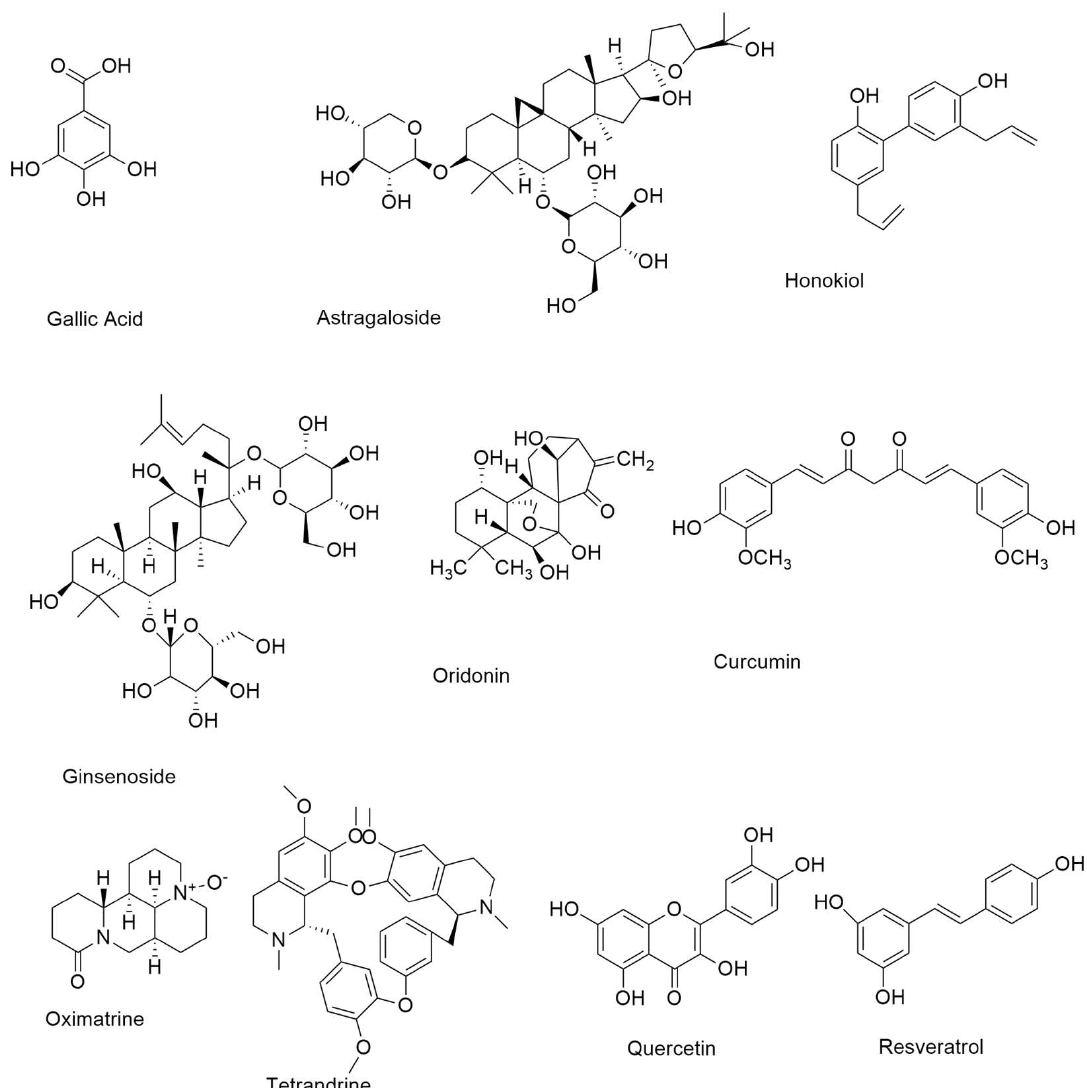
Figure 3. Small molecule natural compounds as EGFR